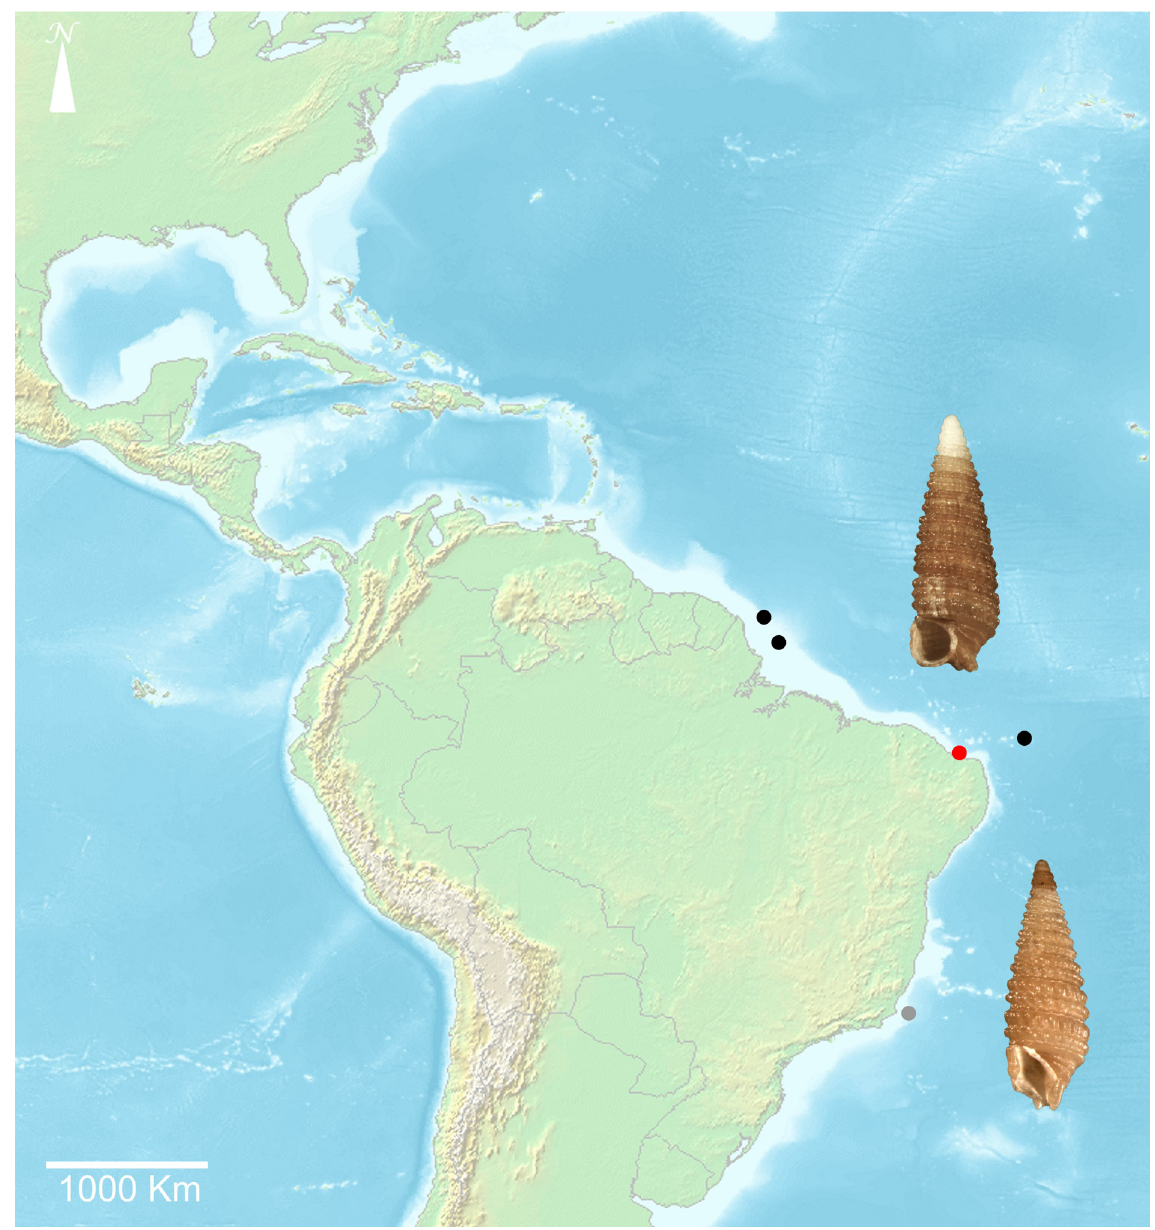
Fig. 64. Distribution map of Sagenotriphora albocaput sp. nov. (red circle = type locality; black circles = additional localities) and Sagenotriphora sp. 2 (gray